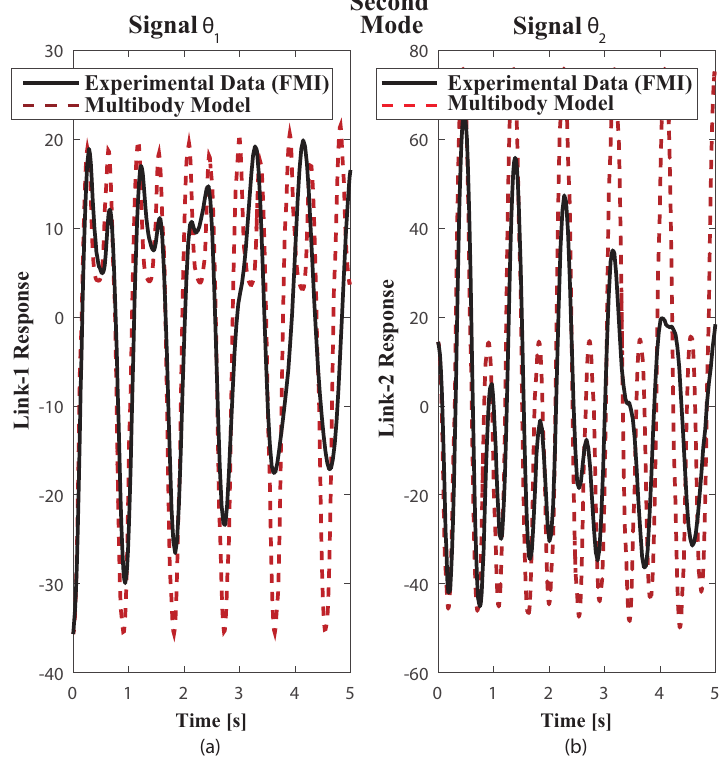
Figure 8. Plots of Experimental FMI and Multibody model free vibration motion responses closely to the second mode. Initial Conditions: first link from vertical Θ 1 = 35.65 ◦ , clockwise, second link from vertical Θ 1 = 14.42 ◦ counter clockwise.